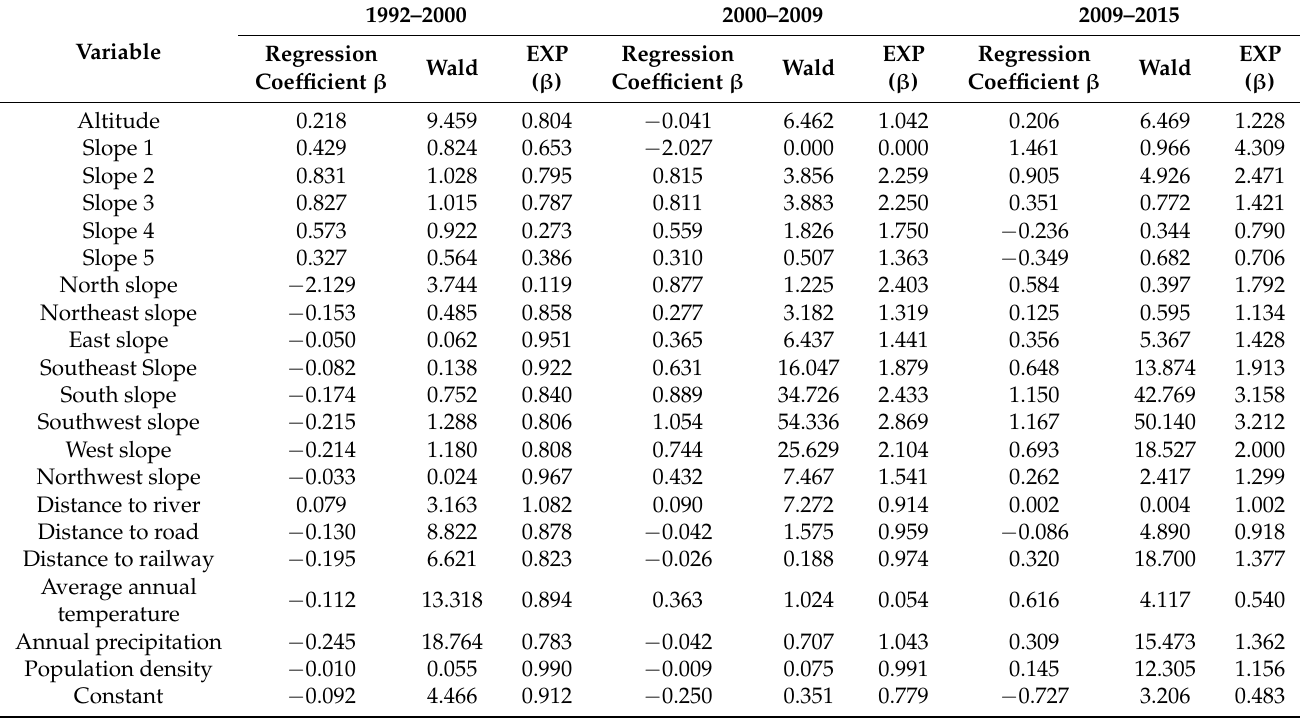
Table A2. Model estimates for cultivated land contraction driving forces.